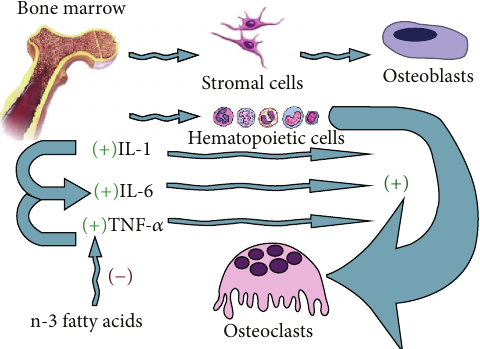
Figure 3: The relationship between cytokines and osteoclastogene- sis. IL-1: interleukine-1; IL-6: interleukine-6; TNF- 𝛼 : tumor necrosis factor- 𝛼